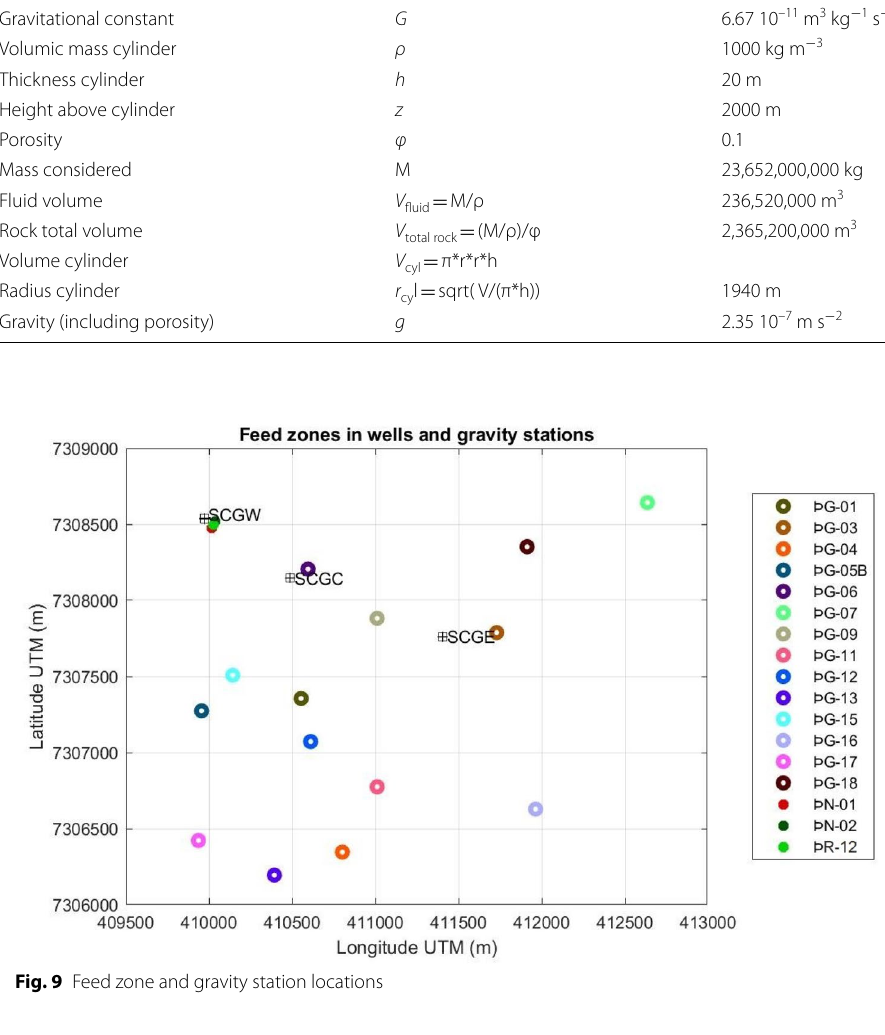
Table 4 Estimation of the gravitational attraction associated with a cylinder a depth Parameter